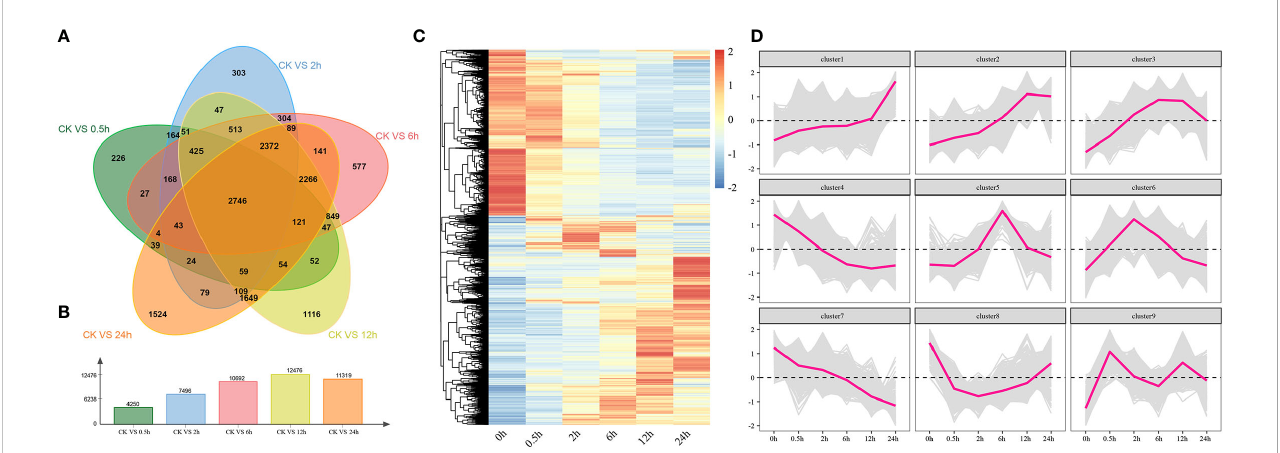
FIGURE 5 The results of differentially expressed analyses and cluster analyses. (A) The amount of shared and different genes that were expressed at DTP under salt stress (B) The number of DEGs at DTP under salt stress (C) The heatmap showed the distinctive expression patterns of DEGs at DTP under salt stress (D) The line graph showed the expression changing trends of genes that were contained in